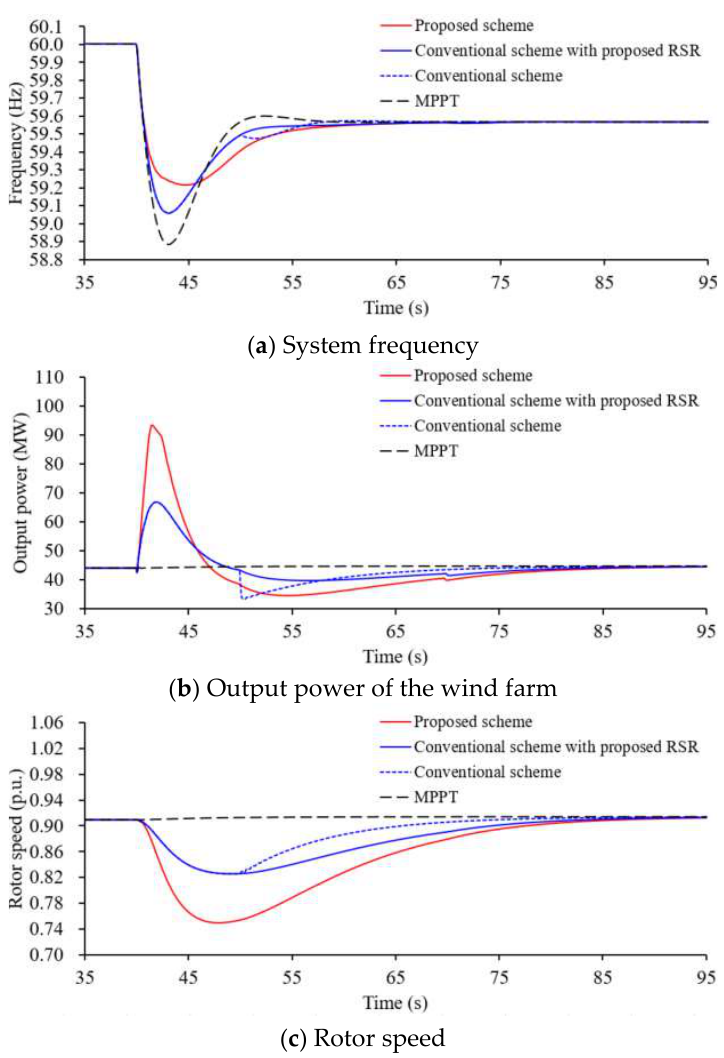
Figure 15. Results for Case 3.